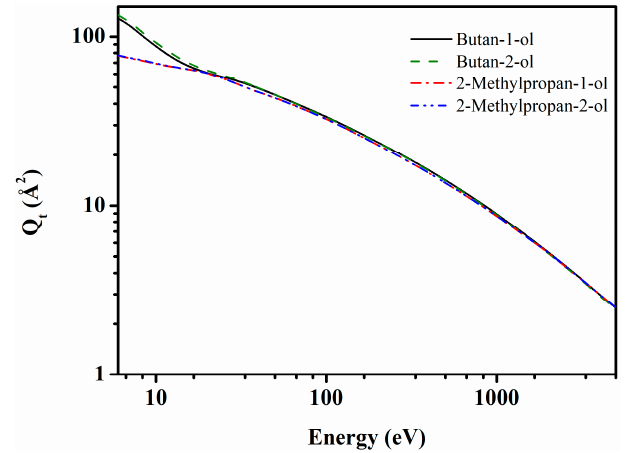
Figure 5. Total cross-section butan-1-ol: black solid line shows present results, red circles are ex- perimental results by Gomes et al., purple squares are ‘hybrid TCS’ by Gomes et al., blue dashed lines are calculated values by Gomes et al., green dash-dot-dot line is from Bhardvaja et al. and orange dash-dot-dash line shows TCS + rotational from Gomes et al.